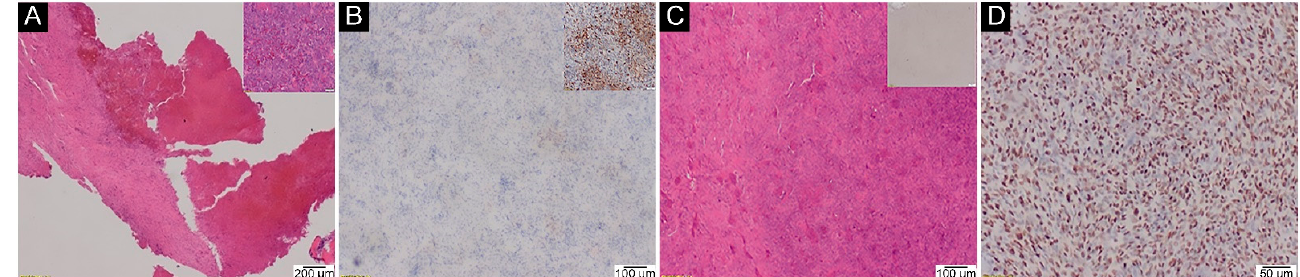
Figure 4. False-negative areas in GCTB patients with p.Gly35Trp mutation detected using anti-histone H3.3 G34W antibody via IHC staining. ( A ) First example: secondary aneurysmal bone cyst formation with a more typical GCTB histology elsewhere (inlet) (H&E, 20×); ( B ) false-negative IHC assay in an area of the cystic degeneration with positive staining in a solid part of the same tumour—photo taken from a different field of view (inlet) (IHC, 40×); ( C ) Second example: histologically typical recurrence of GCTB (H&E, 40×) with false-negative IHC assay (inlet) after decalcification in a strong inorganic acid. Molecular testing for p.Gly35 mutation was also false-negative—sample sent for consultation. Poor tissue quality reflects its partial destruction due to too strong decalcification of the specimen, leading also to a blank appearance of IHC counterstain (inlet); ( D ) positive IHC assay from the same tumour (IHC, 100×) after rebiopsy and mild decalcification in EDTA (mutation confirmed via direct sequencing).